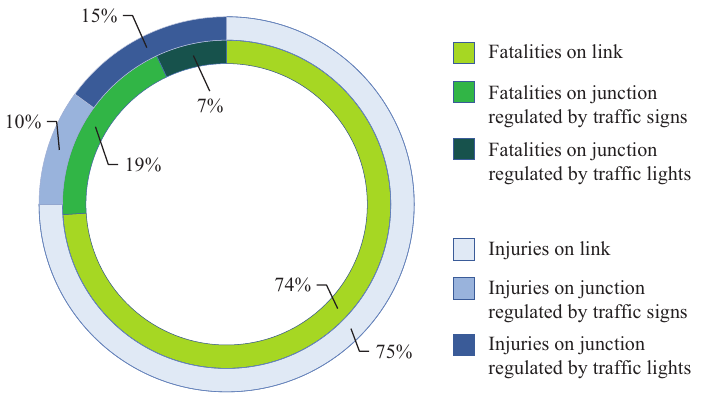
Figure 8. The distribution of fatalities and injuries caused by older pedestrians considering the road accident